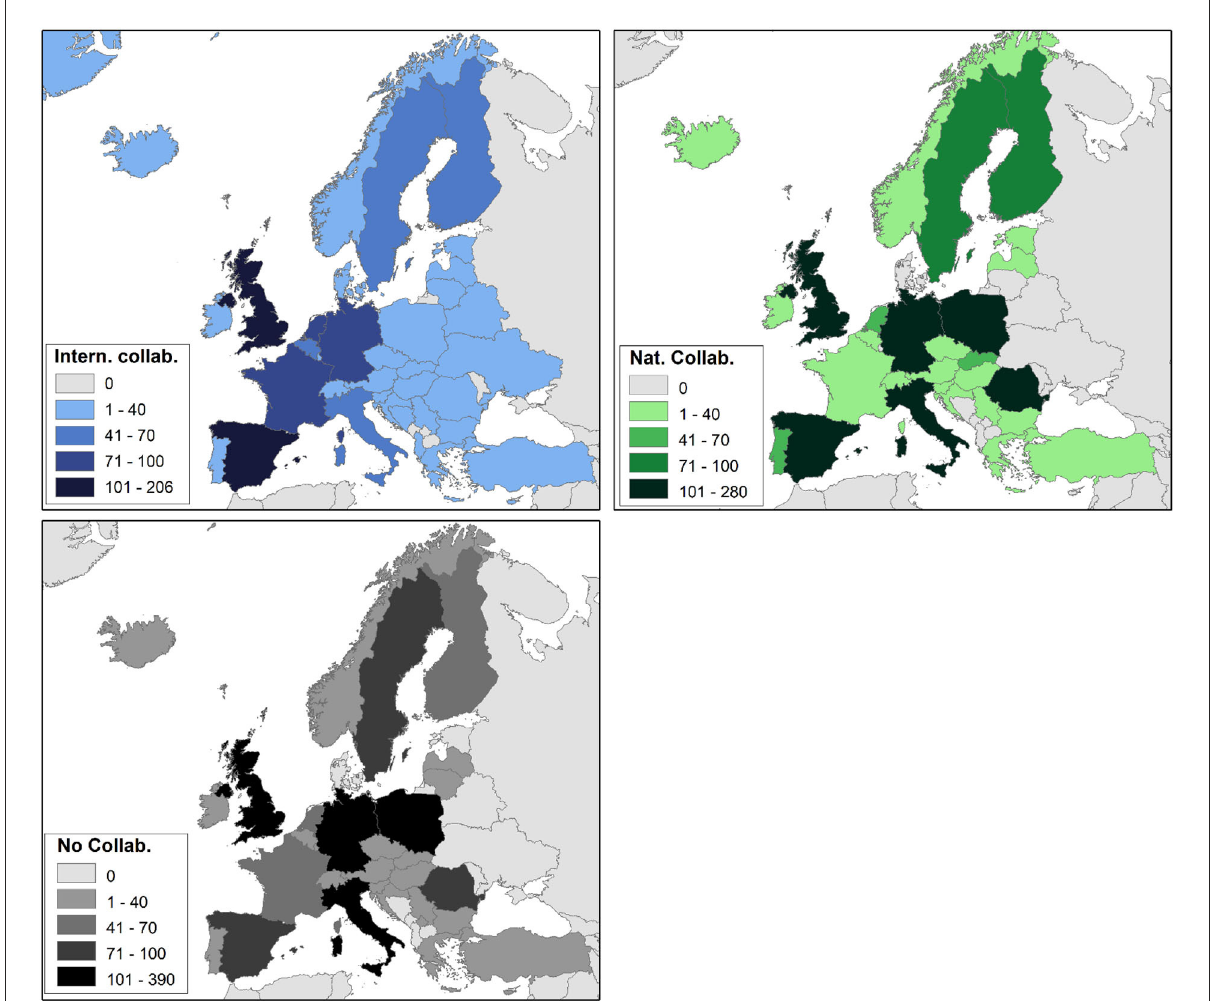
FIGURE3 Collaboration maps by papers authored only by women, with international collaboration (blue), national collaboration (green), and no collaboration (gray).